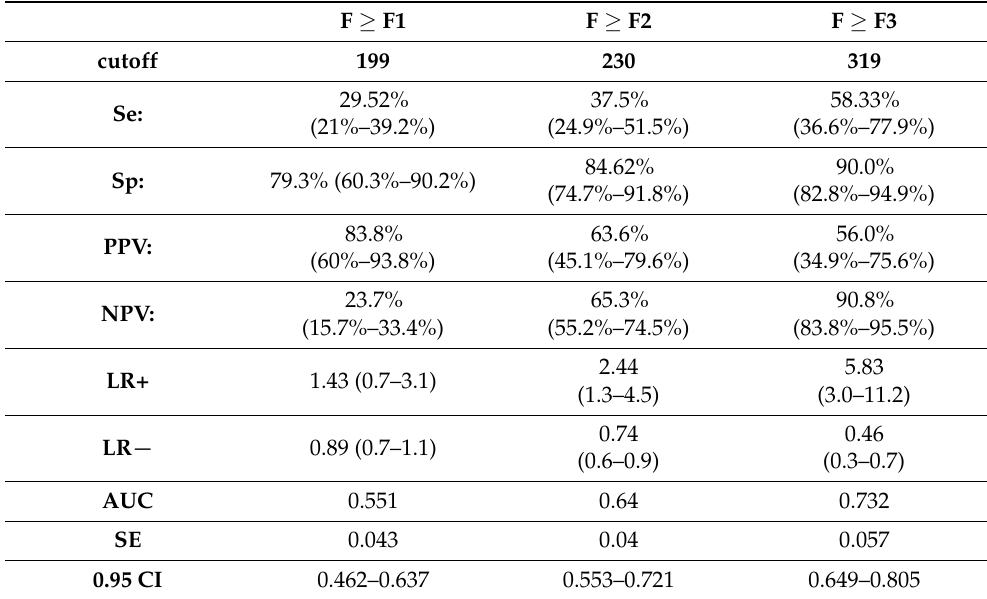
Table 5. The diagnostic performance of M65 for fibrosis grades greater than or equal to 1, greater than or equal to 2, and greater than or equal to 3.